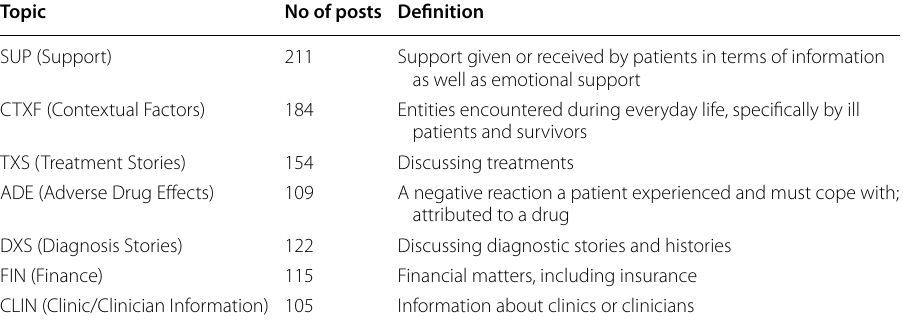
Table 1 Frequency of